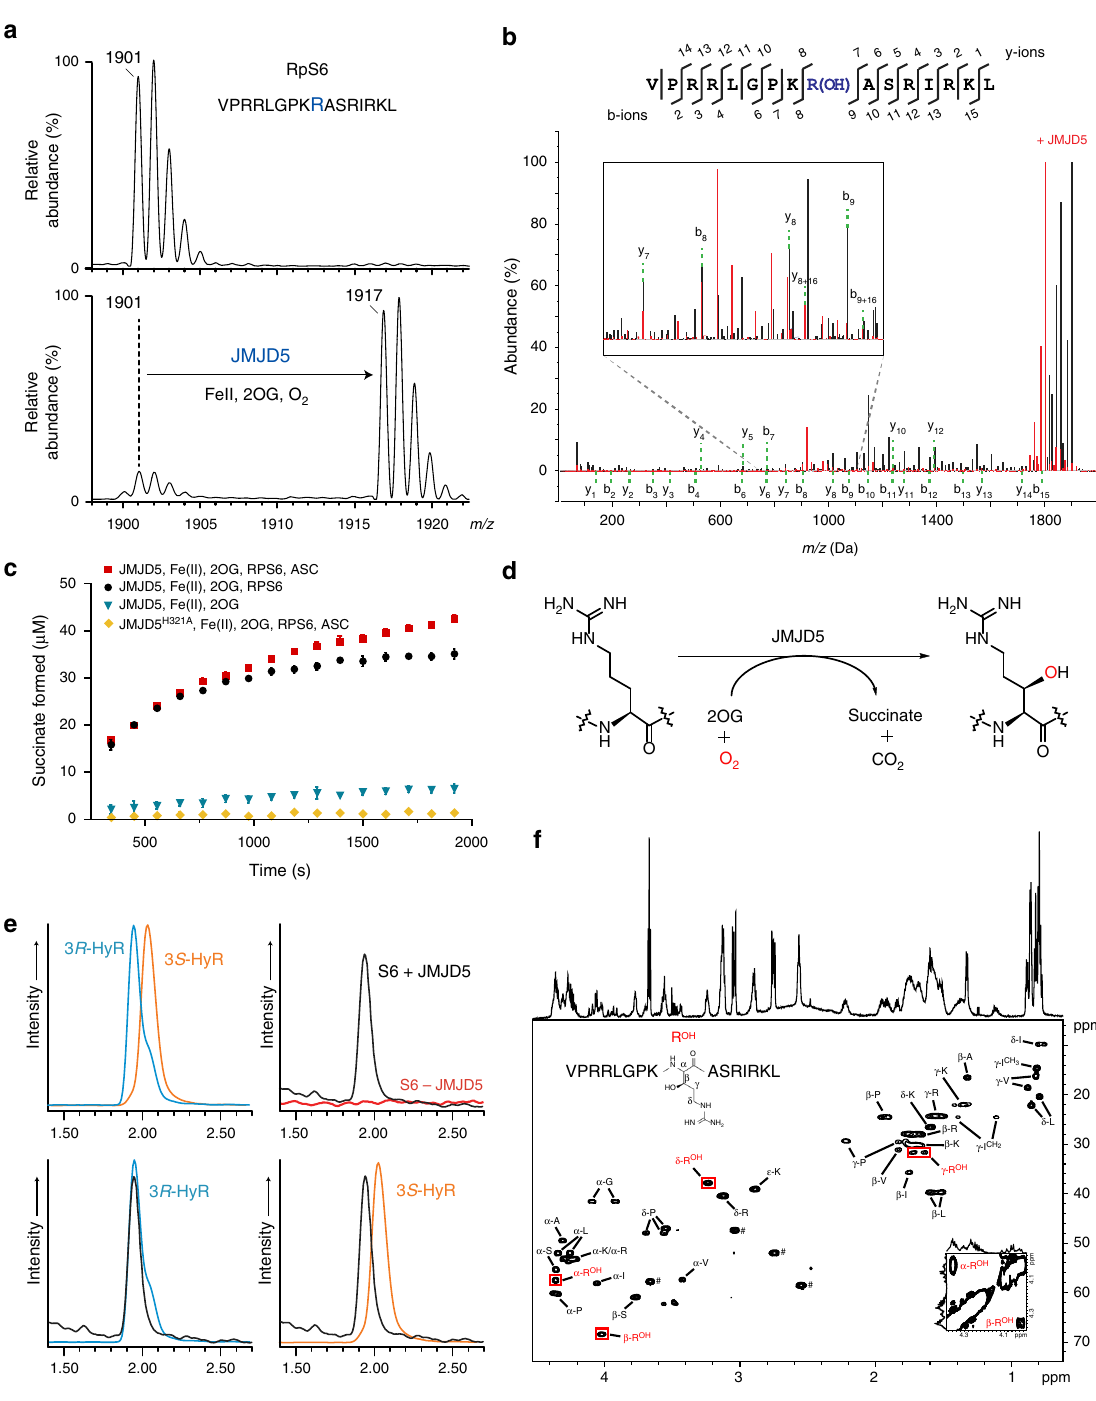
Fig. 1 JMJD5 catalyses stereoselective C-3 hydroxylation of Arg137 of the 40S ribosomal protein S6 (RPS6). a MALDI-MS spectra for RPS6 129 – 144 showing the + 16 m/z shift following treatment with JMJD5 and cofactors. b MS/MS analysis of the modi fi ed RPS6 129 – 144 indicating a + 16 shift on y and b ion fragments y 8 – y 14 /b 9 – b 15 , which is not observed for ion fragments y 1 – y 7 /b 2 – b 8 , implying hydroxylation at RPS6 R137; observed/predicted masses for the fragment ions are given in Supplementary Fig. 5. c Plot of succinate formation monitored by 1 H-NMR. Succinate formation from a reaction with 10 μ M JMJD5, 50 μ M RPS6, 200 μ M 2OG and 100 μ M Fe(II) (black) is compared to that without RPS6 peptide (blue), with ascorbate (red), and with an inactive H321A variant substituting for wild type (yellow). Results are the mean ± s.e.m. ( n = 3). d JMJD5-catalysed arginyl hydroxylation. e Extracted ion chromatograms ( m/z = 345) from LC-MS analysis of synthetic (3 R )- and (3 S )-hydroxyarginine (HyR) standards and amino-acid hydrolysates from unmodi fi ed/hydroxylated RPS6 129 – 144 . Peaks at 1.93 and 2.02 min correspond to (3 R )- and (3 S )-hydroxyarginine, respectively. f 1 H – 13 C HSQC spectra of hydroxylated RPS6 129 – 144 (VPRRLGPKR OH ASRIRKL), labelled with aa assignments, supporting R137 C-3 hydroxylation. Red boxes highlight the hydroxyarginine (R OH ). Inset bottom right: 1 H – 1 H COSY spectrum showing the correlation between C-2-R OH and C-3-R OH protons. ♯ Indicates residual HEPES buffer NATURE COMMUNICATIONS | (2018)9:1180 | DOI: 10.1038/s41467-018-03410-w |